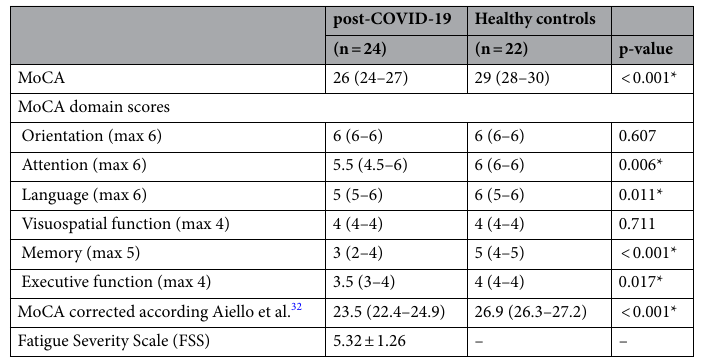
Table 2. Results of cognitive assessment of post-COVID-19 patents. *Statistically significant